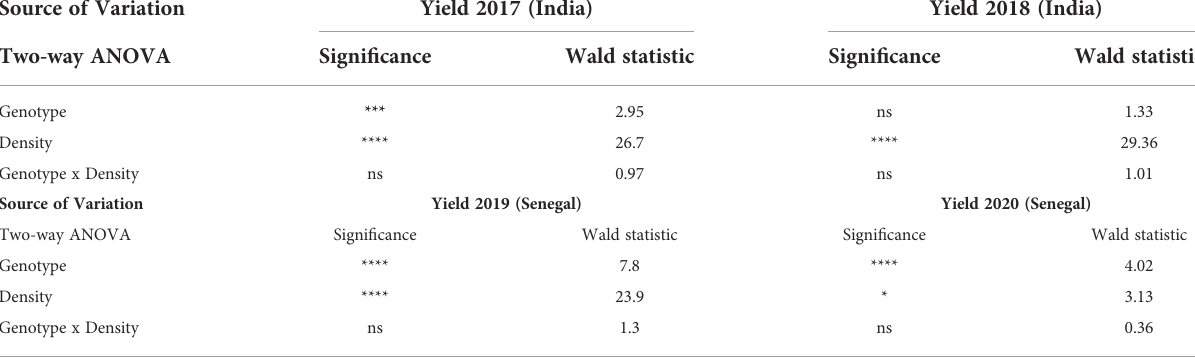
TABLE 1 Two way ANOVA table showing signi fi cance and Wald statistic for the yield obtained in two different density (HD, LD) in India in 2017 and 2018 and in the three different density (D1, D2, D3) in 2019 and 2020 in